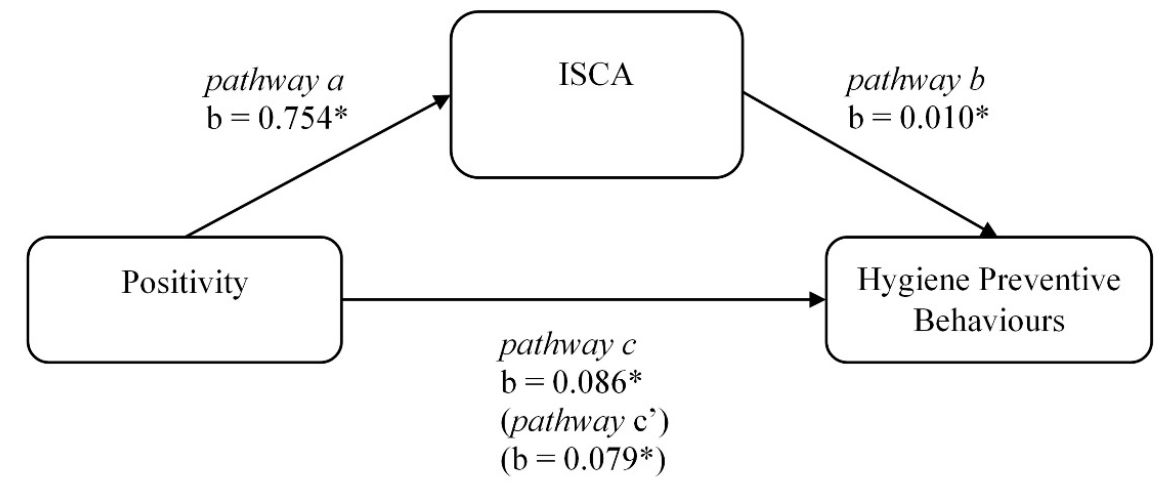
Figure 2. Mediation model of positivity and COVID-19 preventive behaviours related to hygiene through the impact of social closeness on altruism ( n = 460). Note : b = unstandardized coefficients. * p < 0.05. ISCA: The impact of social closeness on altruism index.